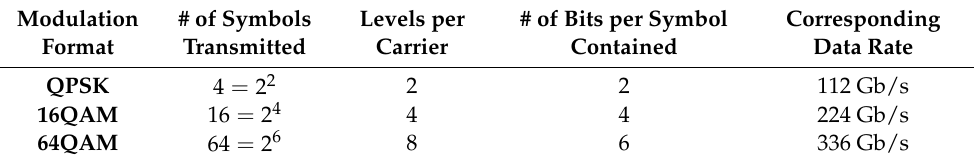
Figure 15. The NMSE vs. the number of FFT blocks for various algorithms for a PDM-64QAM signal; inset: constellation diagrams before ( right ) and after ( left ) the STBC-RLS compensation [27]. Table 1. Comparison of multiple modulation formats [21]. QPSK—quadrature phase shift keying; QAM—quadrature amplitude modulation.